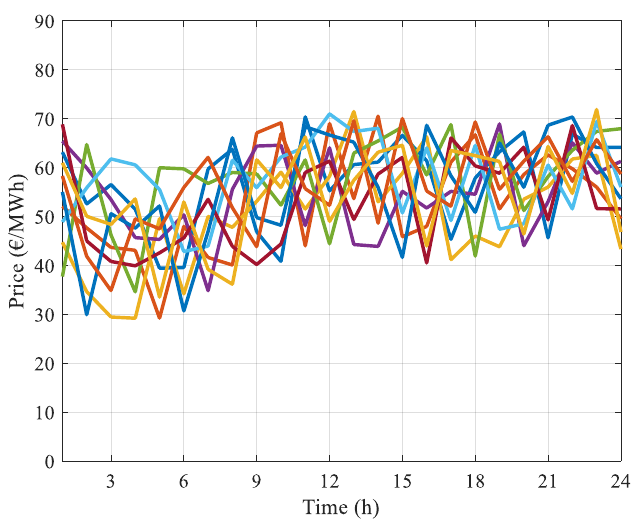
Figure 1. Scenarios of day-ahead market prices.